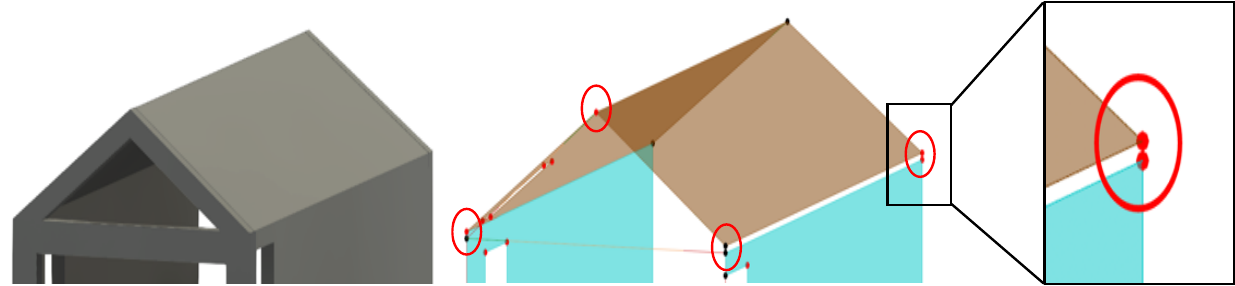
Figure 4. Physical model of the roof and disconnected nodes in the analytical model.